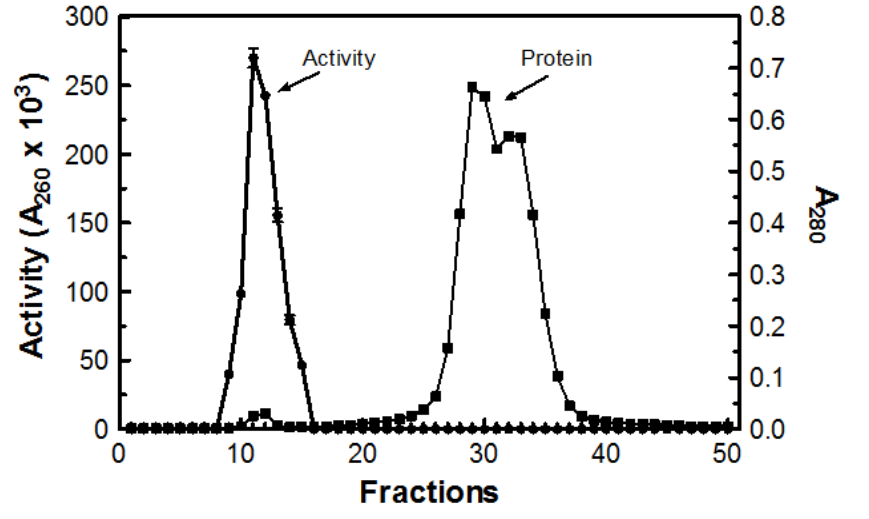
Figure 6. Purification profile of DNase activity and protein. Concentrated sample (1 mL) was passed through a Sephadex G-50 column at 2–5 °C. The DNase activity was